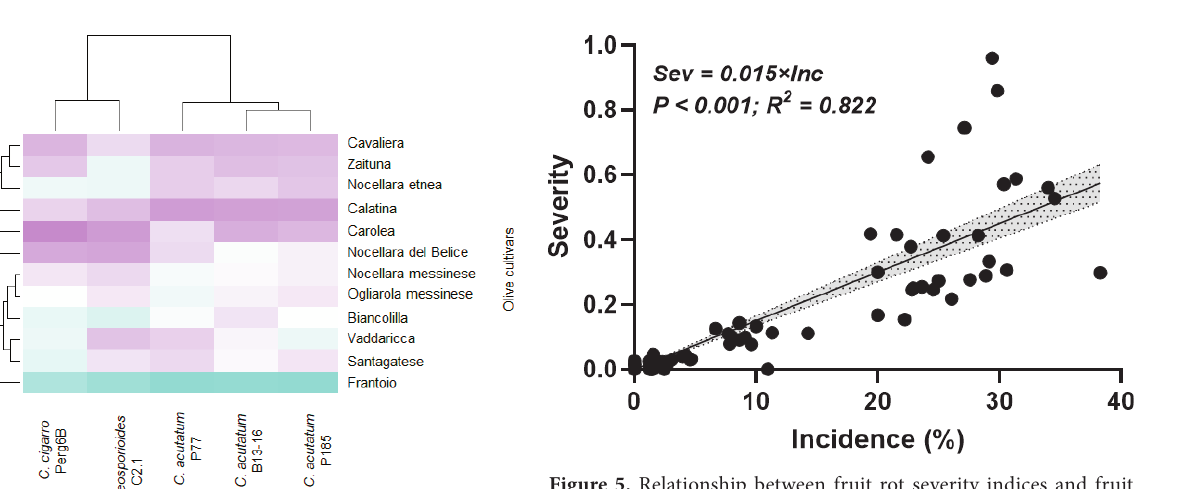
*One way ANOVA was performed on AUDPC values. Means within each column accompanied by the same letter are not significantly dif- ferent ( P < 0.01), Student-Newman-Keuls test.